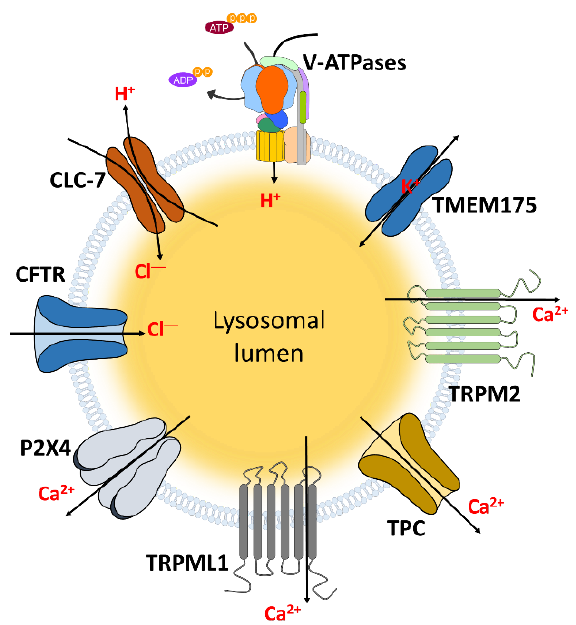
Figure 1. The channels localized in lysosomal membrane to transport ions. These channels and transporters can regulate lysosomal and cellular functions through transporting and maintaining hydrogen, chloride, Ca 2+ , and potassium which indicated in table 1.